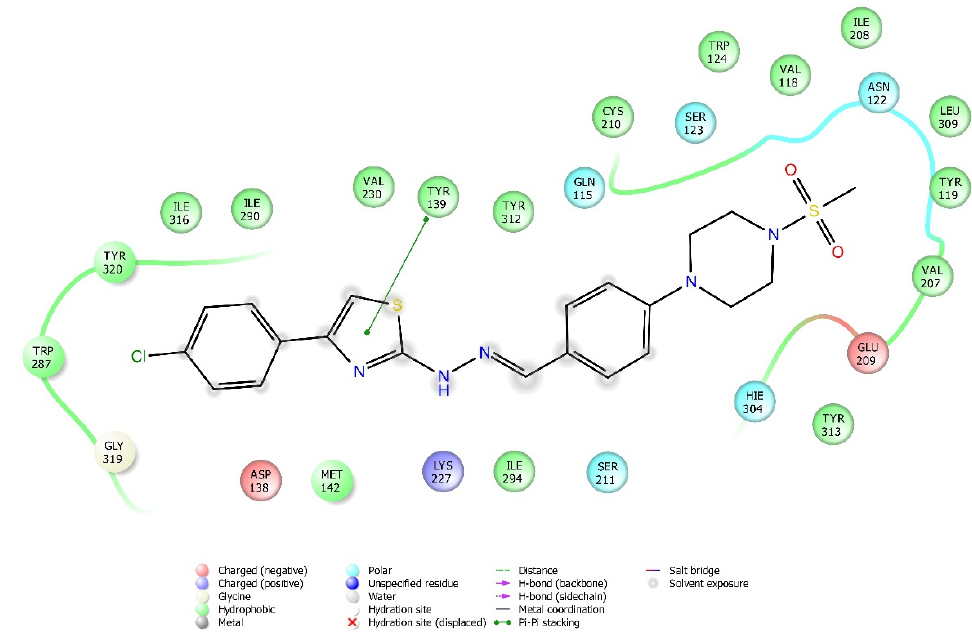
Figure 22. The three-dimensional interacting mode of compound 3f in the active region of ĸ -opioid receptor. The ligand and significant residues of the active site of the receptor are presented by a tube model colored with green and white, respectively (PDB Code: 6B73).